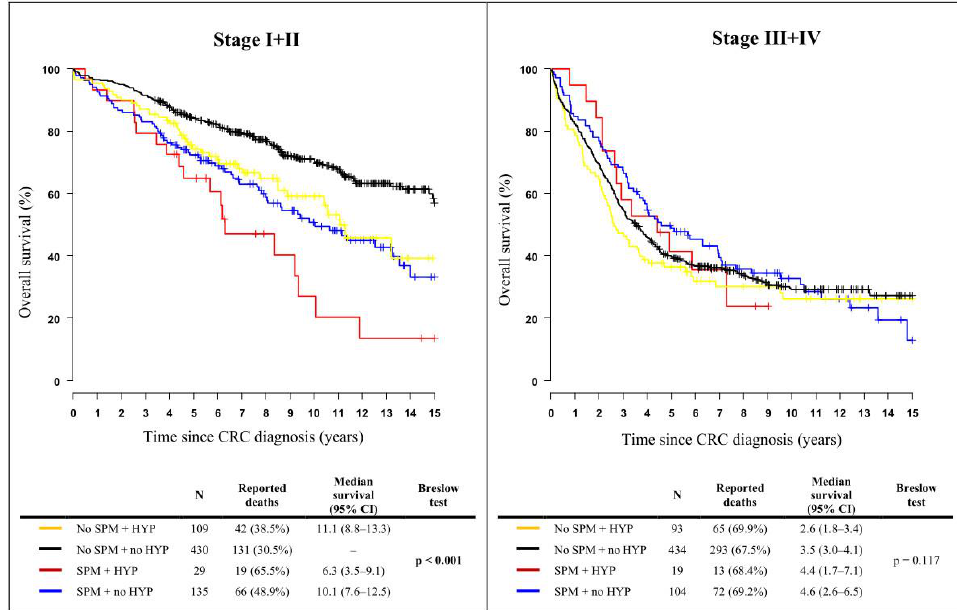
Figure 2. Kaplan − Meier curves of a 15-year survival among colorectal cancer patients (C18–C20), stratified by the occurrence of a second primary malignancy and the use of hypolipidemic drugs, according to clinical stages. SPMs, second primary malignancies; HYP, hypolipidemic treatment; CRC, colorectal cancer.